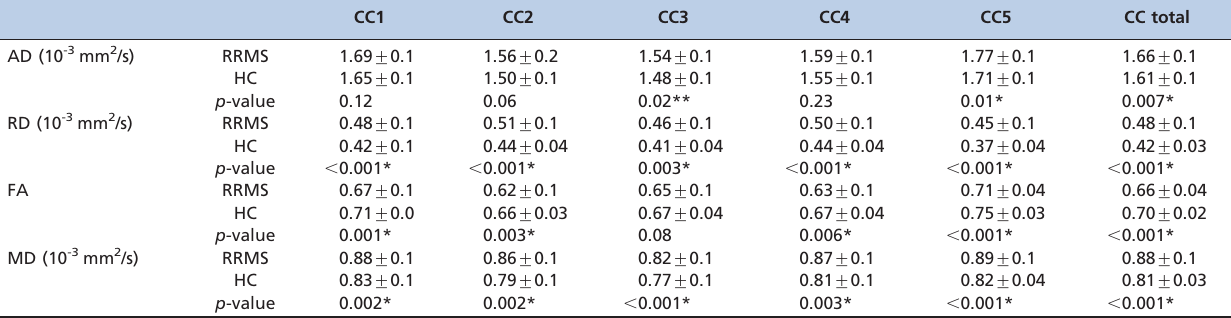
Table 2 - Diffusion tensor imaging indices and volumetric results in the corpus callosum segments in the relapsing- remitting multiple sclerosis and healthy control groups.